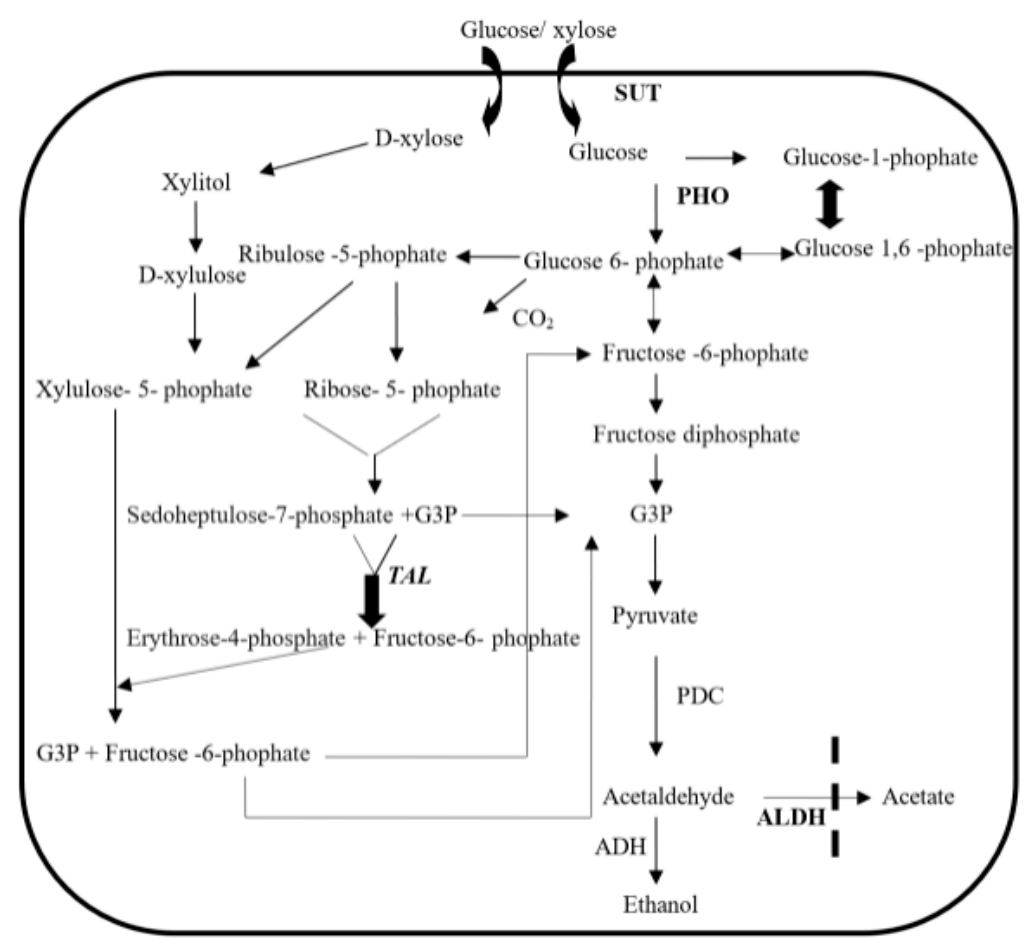
Figure 1. Metabolic pathways for glucose and xylose in F. oxysporum [10,12,13]. Aldehyde dehydrogenase (ALDH) (EC 1.2.1.5) converts acetaldehyde into